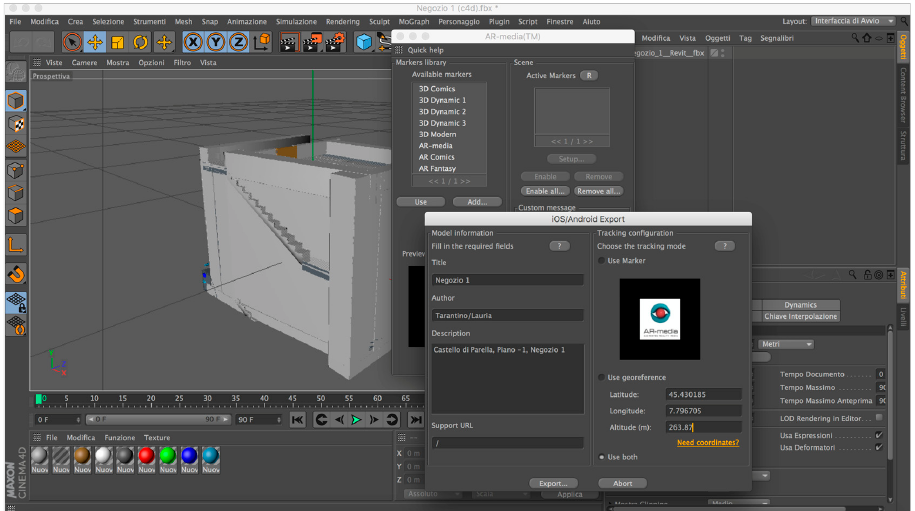
Figure 13. Georeferencing of the model in Cinema 4D.